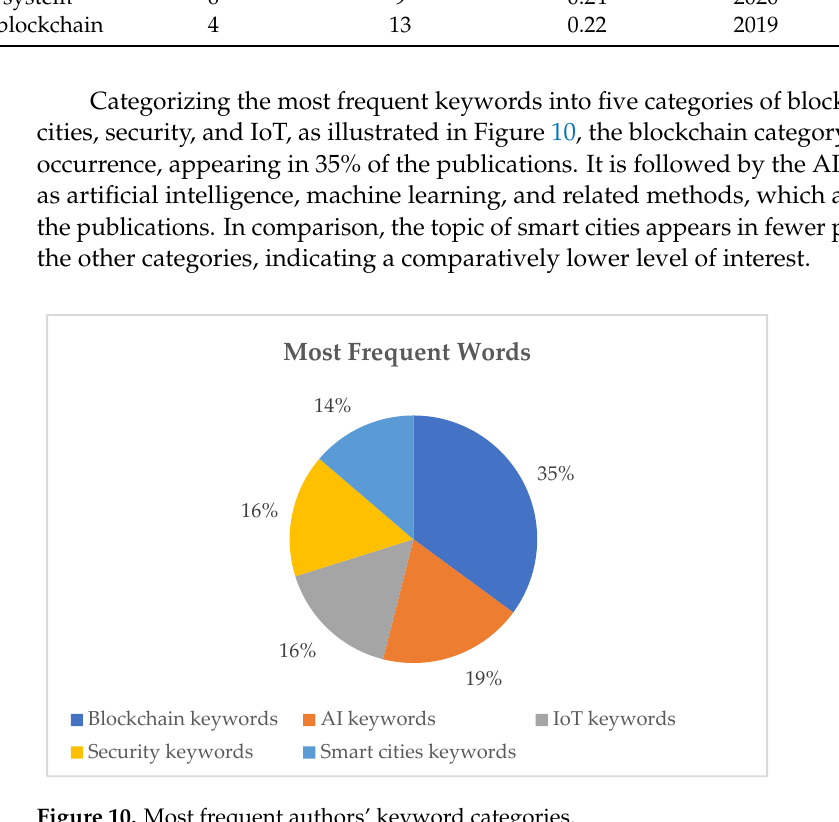
Figure 10. Most frequent authors’ keyword categories.